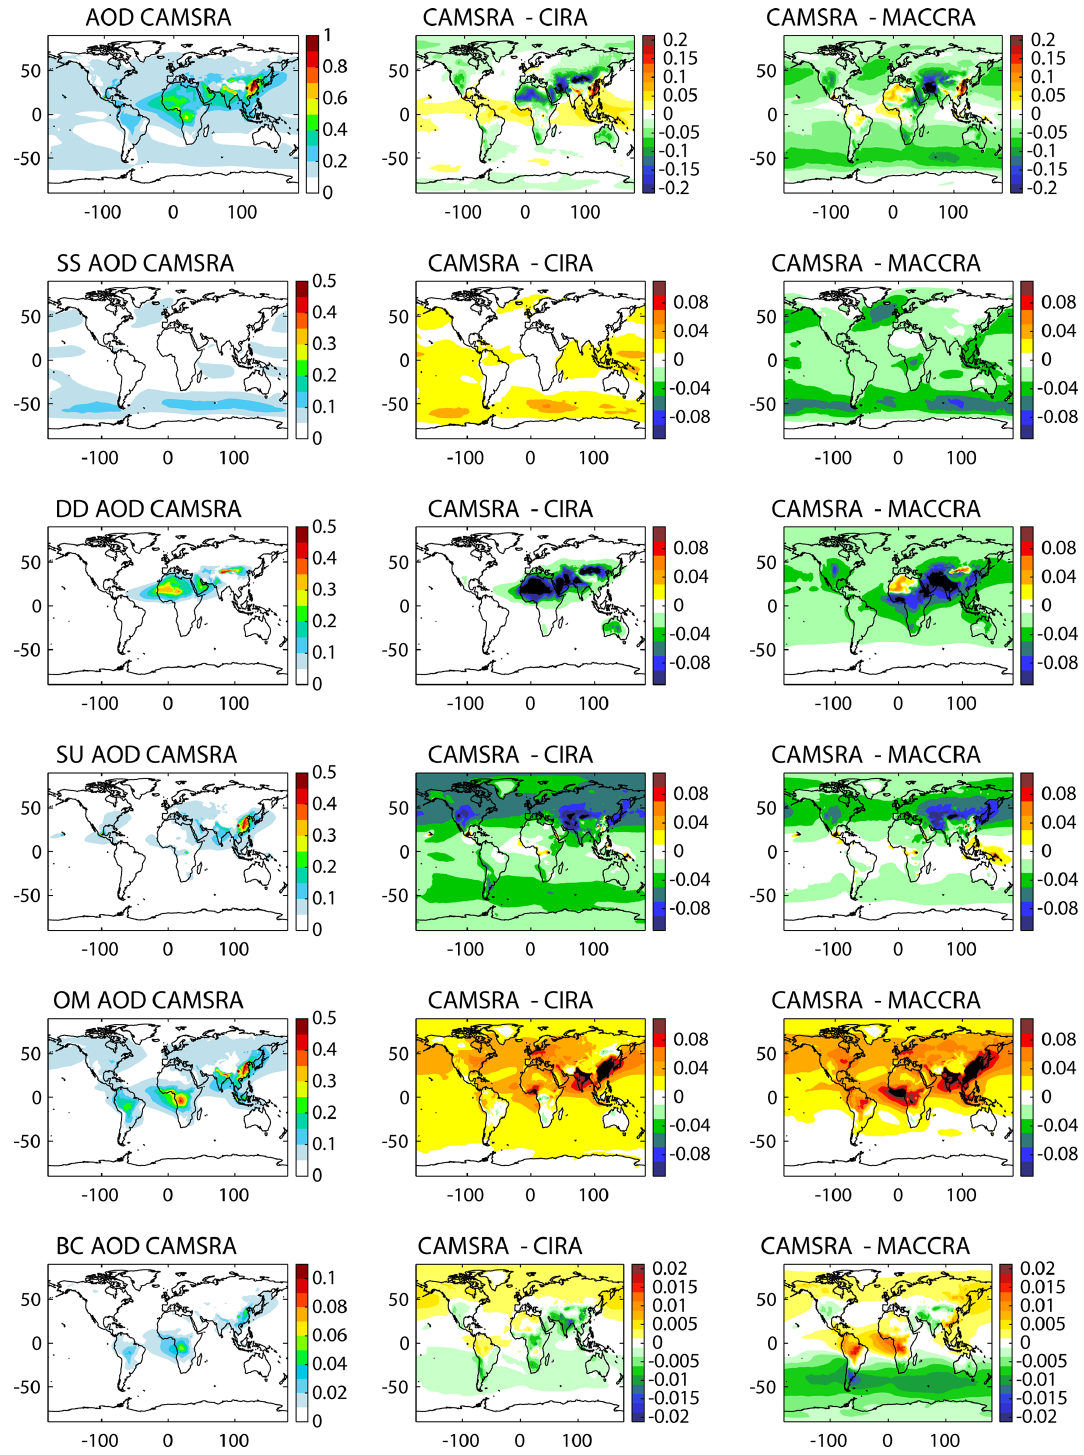
Figure 20. Annually averaged AOD species from CAMSRA (2003–2016, left), difference between CAMSRA and CIRA (middle), and difference between CAMSRA and MACCRA (right, 2003–2012 only) for total AOD (row 1), sea salt (row 2), desert dust (row 3) and sulfates (row 4), organic matter (row 5), and black carbon (row 60). AOD is